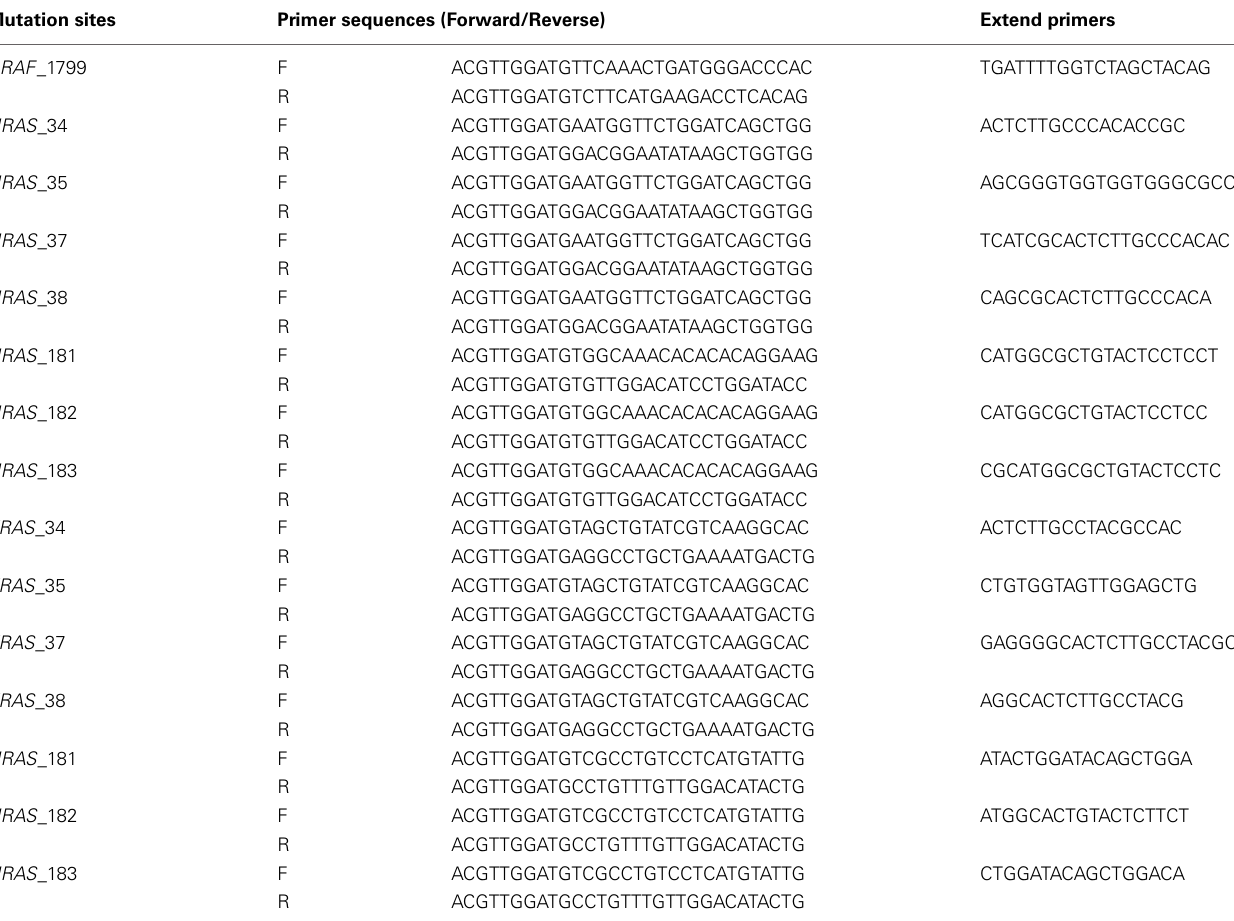
Table 2 | Primer sequences used for mutation analysis (MALDI-TOF-MS assays). Mutation sites